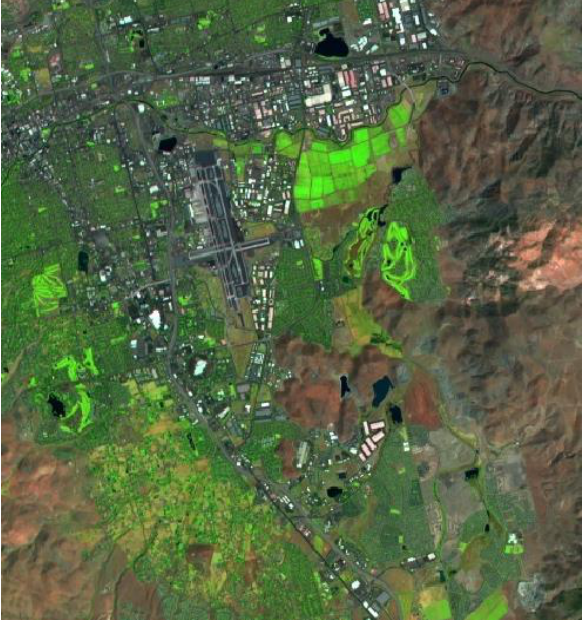
Figure 3. OLI image of Reno, California produced in real-time with band combinations